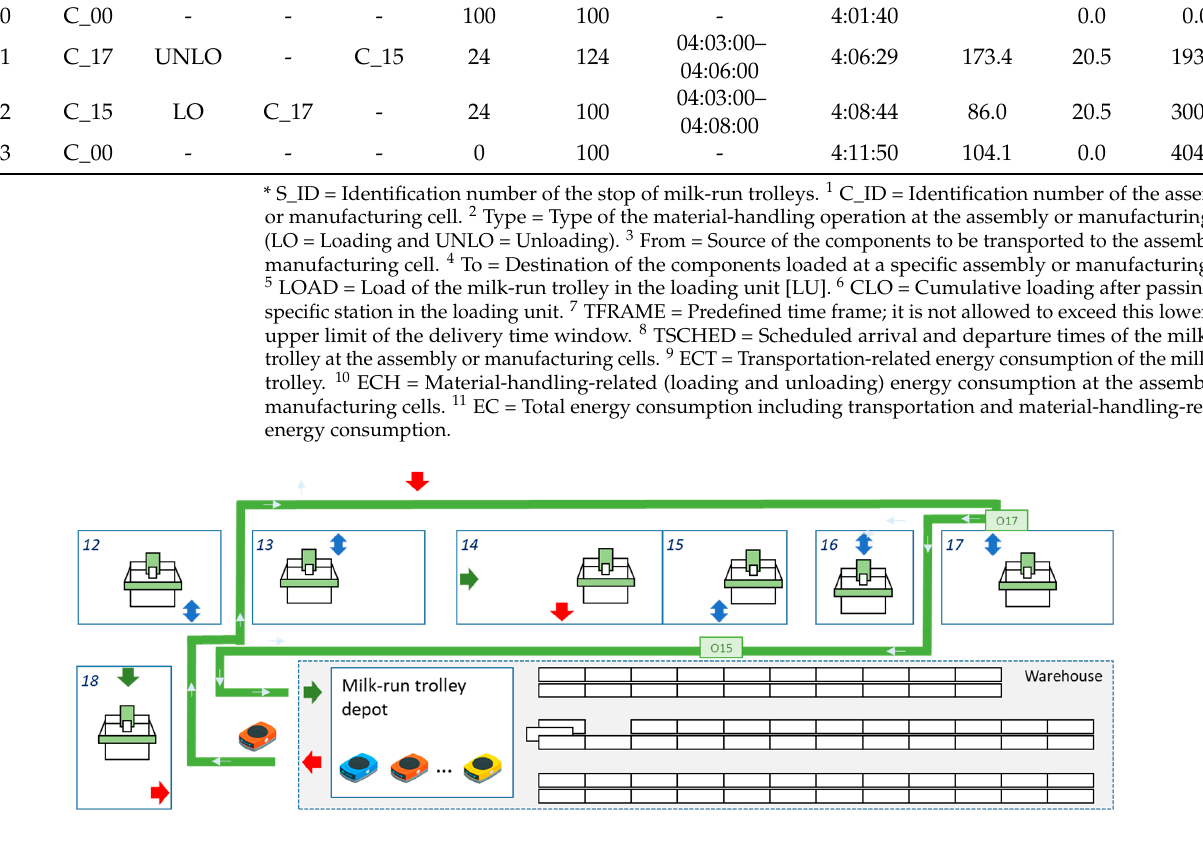
Figure 9. The second route of the conventional milk-run-based in-plant supply including real-time supply demand. Table 7. Numerical results of the conventional optimization of real-time supply demands per- formed by the milk-run trolley within the additional route 5.